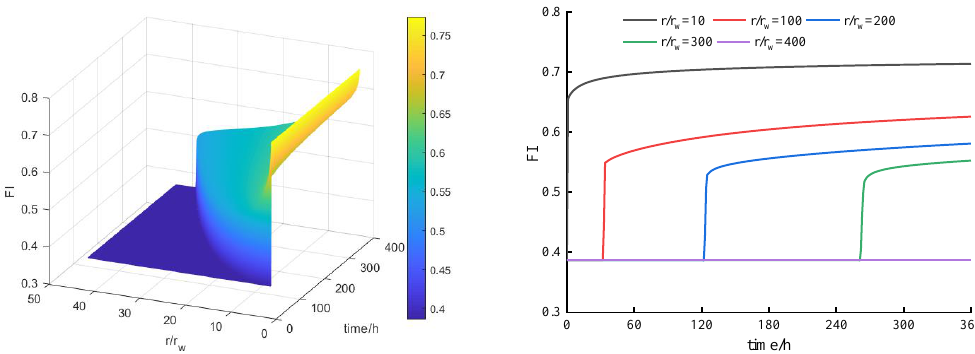
Figure 7. Variation of fracability index with dimensionless distance and